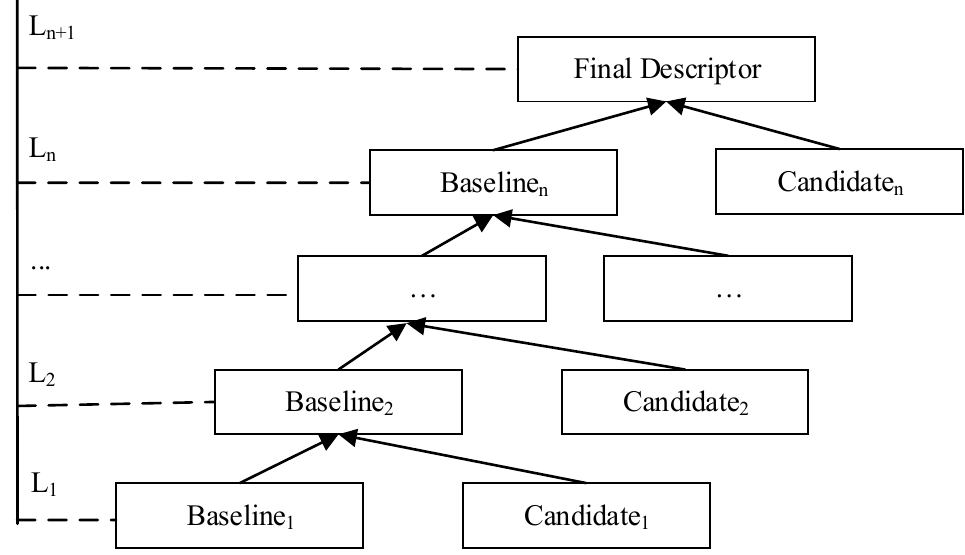
Figure 3. The flowchart of multi-level learning model for fusion of multi-scale feature sets.